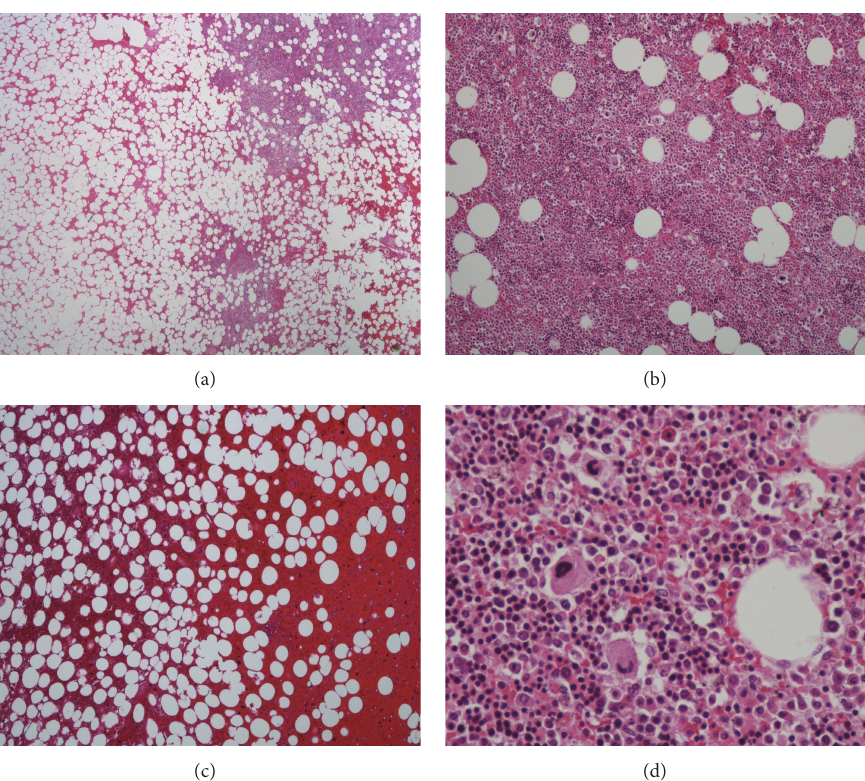
Figure 5: 84-year-old male with presacral myelolipoma. Microscopic examination: the tumor was composed of varying amounts of mature adipose tissue admixed with hematopoietic elements ((a) and (b): H&E, x40); there were also dispersed hemorrhagic areas ((c): H&E, × 40). In higher magnification view the presence of the three cell lineages (myeloid, erythroid, and megakaryocytic) was evident, similarly to the normal bone marrow ((d): H&E, ×